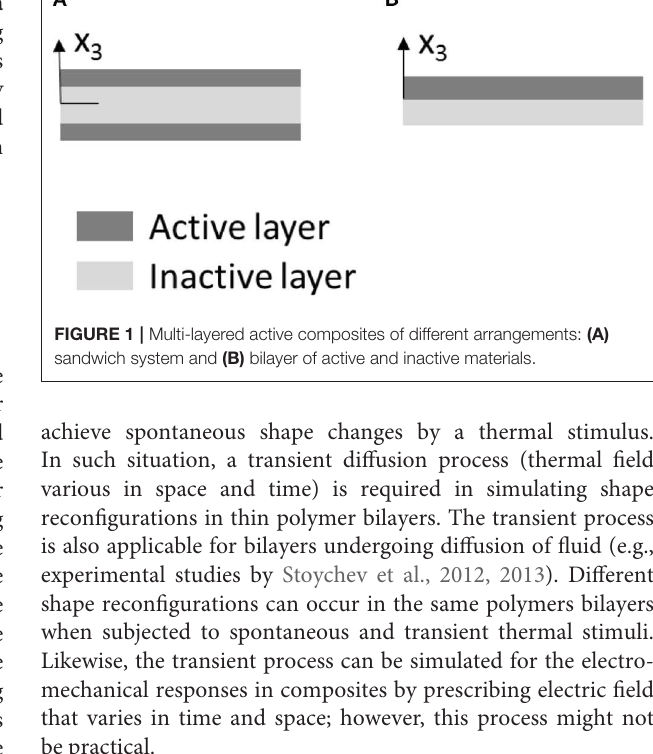
achieve spontaneous shape changes by a thermal